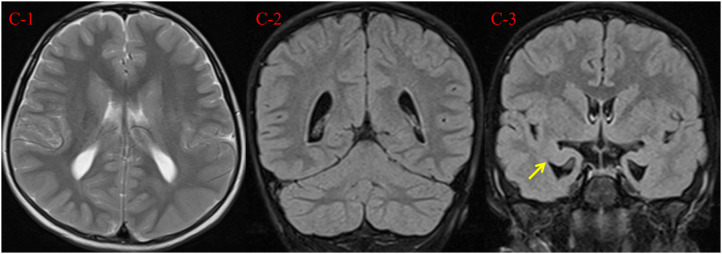
Brain MRI findings at 7 years and 2 months. (C-1, C-2) Axial T2 weighted image and coronal T2 FLAIR demonstrate mild enlargement of the lateral ventricles. (C-3) Coronal T2 FLAIR demonstrates reduced volume of the bilateral hippocampus (arrow), with peculiar temporal horn dilatation.